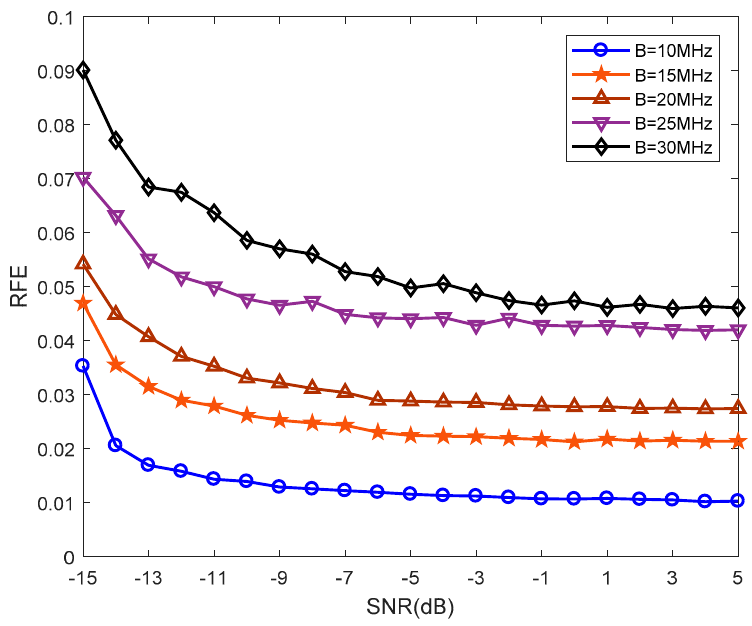
Figure 11. Relative frequency error of frequency estimation.